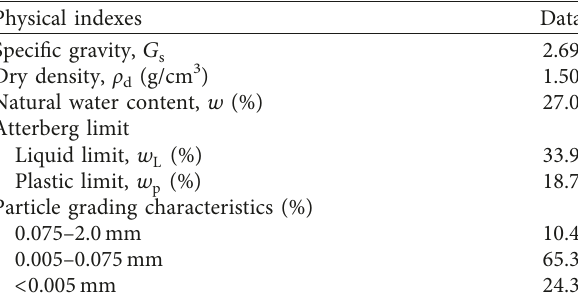
Table 2: Physical indexes for the taken